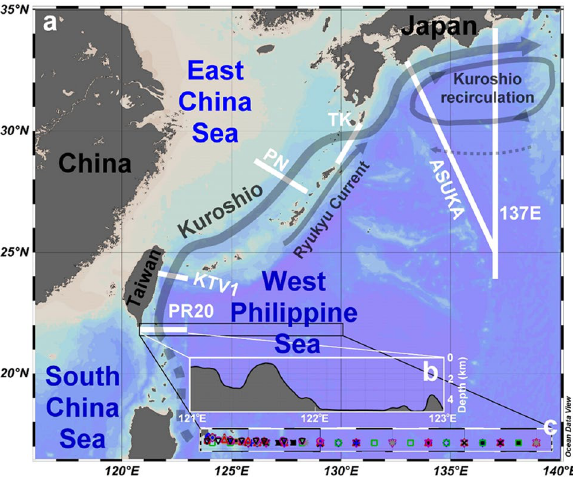
Figure 1. Study area. ( a ) The thick white lines represent different studied cross-sections, and the arrows denote the schematic current paths. ( b ) The bathymetry along the PR20 cross-section. ( c ) The sampled stations. The color symbols depict the sampling locations for cruises listed in Table S1.